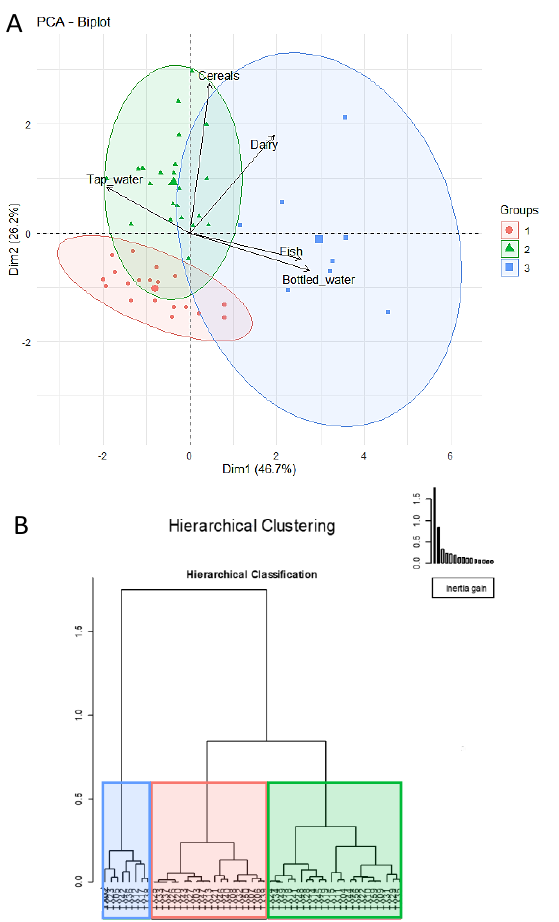
Figure 1. ( A ) Principal Component Analysis (PCA) of the consumption of each food group according to the dietary habits of the women participating in the study. The variables with a cos 2 > 0.2 are represented as black arrows. Samples in Cluster 1 are represented as red dots, in Cluster 2 as green triangles, and in Cluster 3 as blue squares. Ellipses were obtained at a significance of 95%. The dairy products group includes milk, cheese and yogurt; the cereals group includes bread, pasta and rice, and the fish group includes fresh tuna, canned tuna, salmon, swordfish and other fish. ( B ) Dendrogram generated by hierarchical clustering on principal components using Ward’s method (agglomerative hierarchical clustering procedure) of the women participating in the study according to their dietary habits.